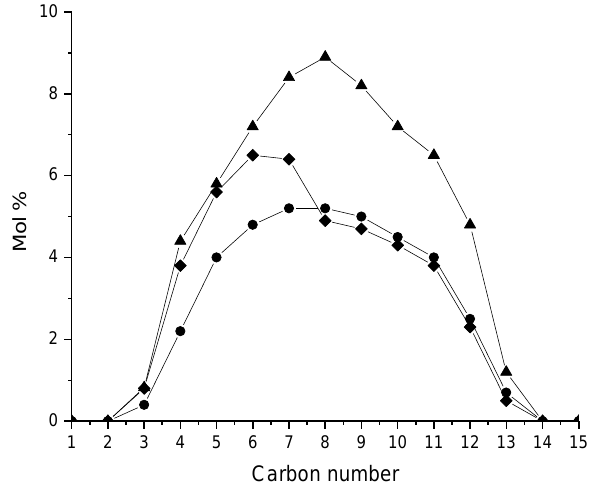
Figure 11. The distribution of cracked products in hexadecane hydroisomerization over Pt-HY-30 (diamond), Pt-Al-MCM-48 (cirle, and Pt-HY-acid leached at 45% yield of cracking products